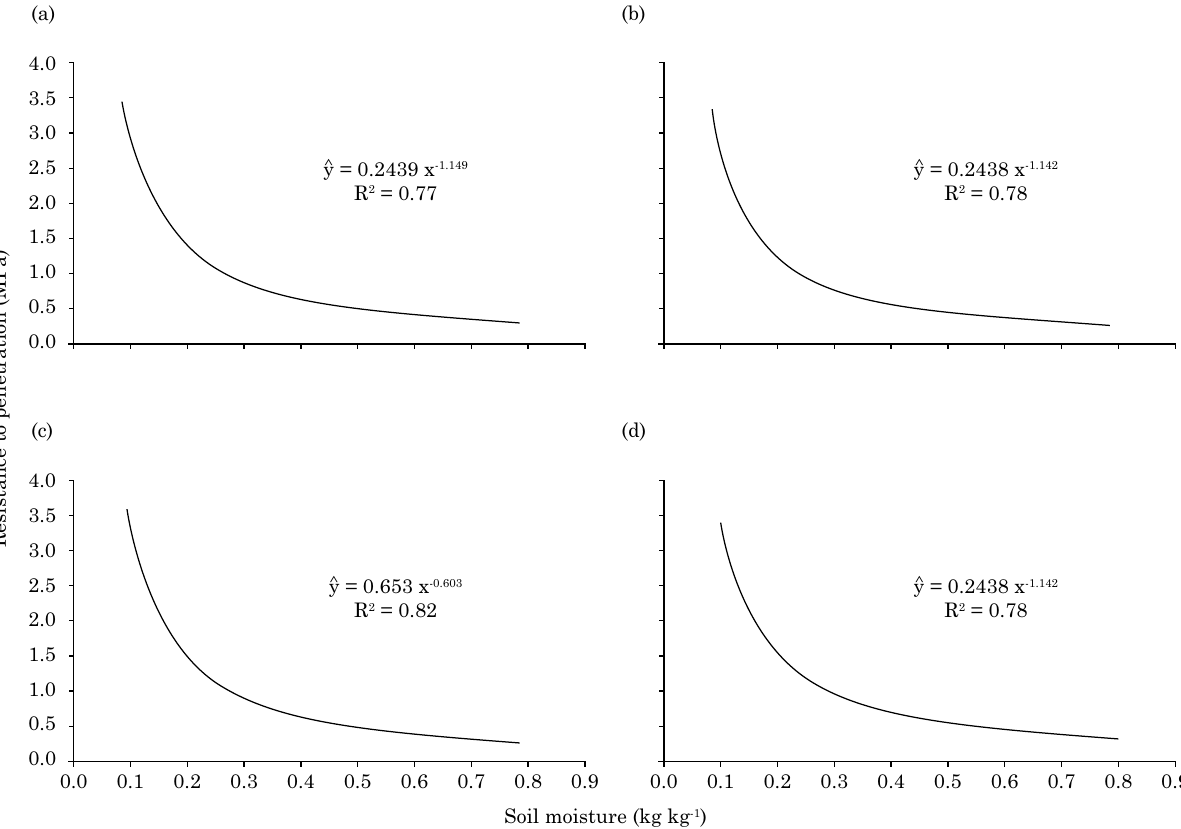
Figure 3. Modeling of soil resistance to penetration at varied moisture levels in Latossolo Vermelho-Amarelo distrófico (Oxisol)under no-tillage system (a), natural forest (b), sheep grazing (c) and natural forest and no-tillage system